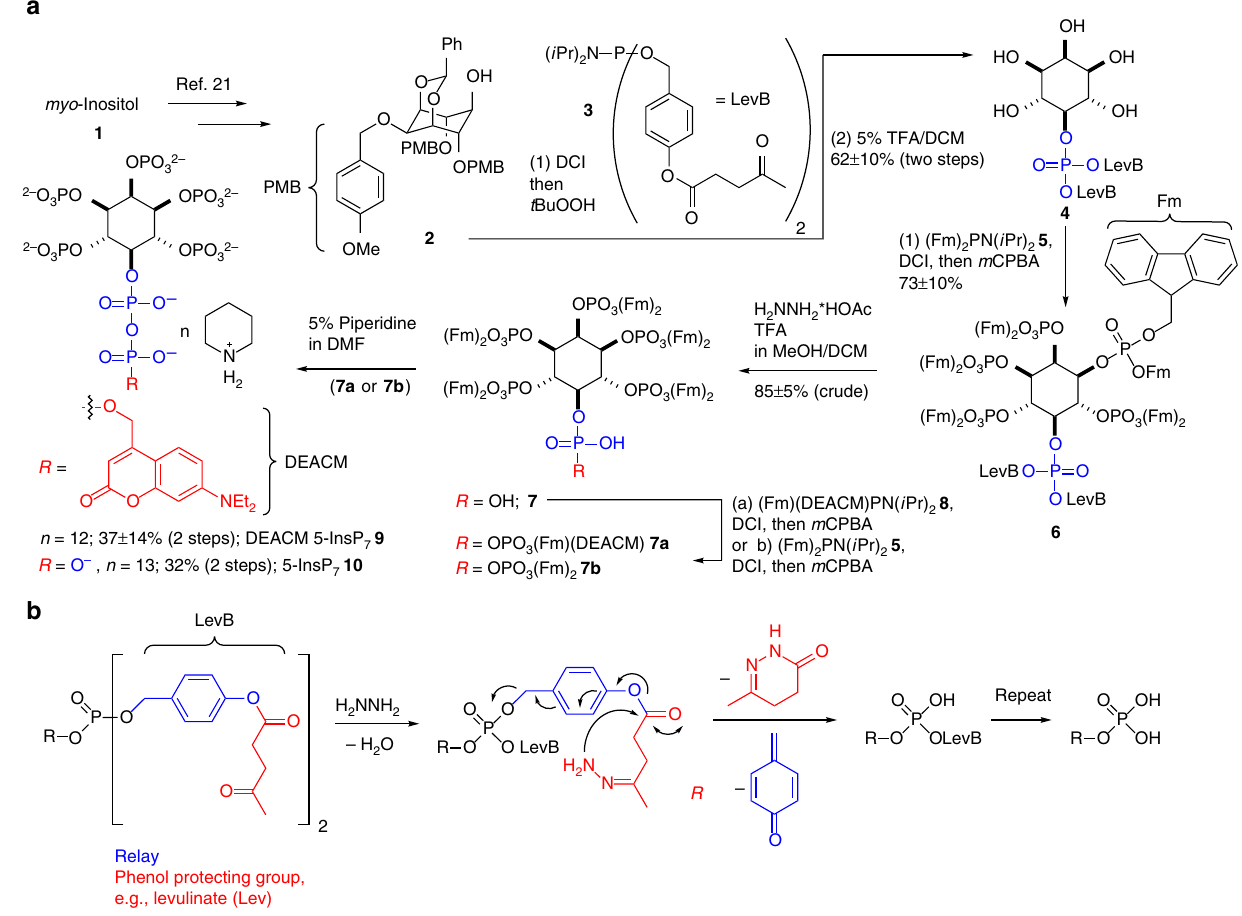
Figure 2 | Synthesis of photocaged 5-InsP 7 and mechanism of LevB cleavage. ( a ) Synthesis of DEACM 5–InsP 7 9 and 5-InsP 7 10 based on fluorenylmethyl (Fm) protection and a novel phosphate-protecting group (LevB). DCI, 4,5-dicyanoimidazole; DEACM, [7-(diethylamino)-coumarin-4- yl]methyl; Fm, fluorenylmethyl; m CPBA, metachloro perbenzoic acid; TFA, trifluoroacetic acid. ( b ) An adaptor strategy for phosphate release: hydrazine triggers levulinate (red) cleavage and 1,6-elimination (blue) to release free phosphate. Generally, levulinate could also be replaced with other phenol protecting